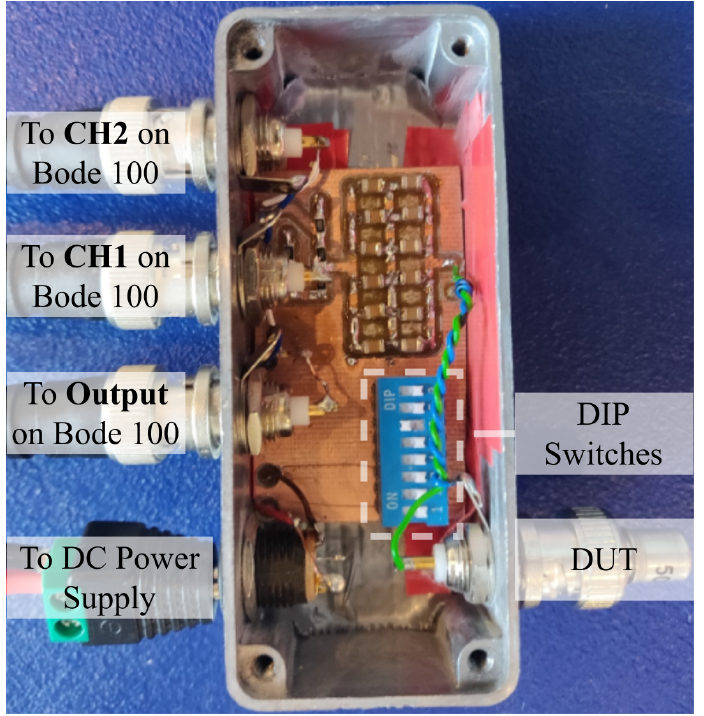
Figure 21. A photograph of the constructed measurement circuit. The aluminium lid was replaced prior to commencement of the measurements. Developed from